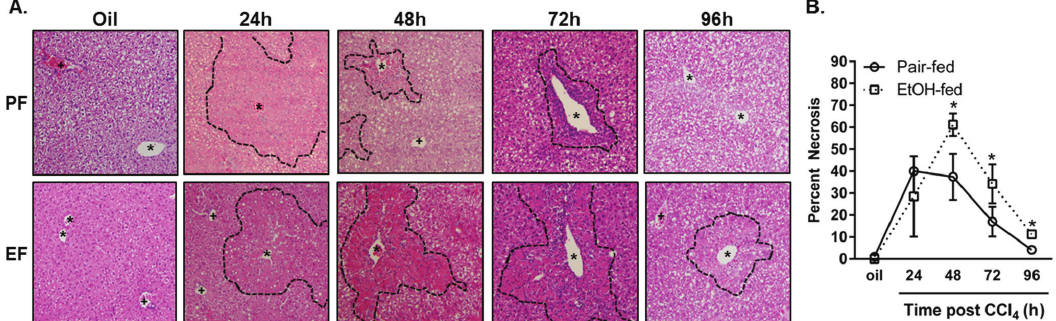
Figure 3. Moderate ethanol feeding delayed removal of nectrotic tissue after CCl 4 exposure. Mice were allowed free-access to a 2% ( v / v ) ethanol containing diet for 2 days and then were exposed to CCl 4 and euthanized 24, 48, 72 or 96 h thereafter while remaining on the ethanol diet. Control animals were pair-fed a diet that isocalorically substituted maltose dextrins for ethanol. ( A ) Representative micrographs taken of hematoxylin and eosin stained liver sections taken at the time points indicated. The dashed line demarks boundary of injured (24 h) or necrotic hepatocytes (48, 72, 96 h). PF = pair-fed, EF = ethanol-fed, asterisk = central vein, plus sign = portal vein; ( B ) Percent necrotic area graphed over time post CCl 4 in pair- and ethanol-fed mice. N = 4–8 mice per group. Because liver injury was not different between diet groups, these data suggest that there is an impaired ability of the ethanol-exposed liver to remove necrotic tissue (Table